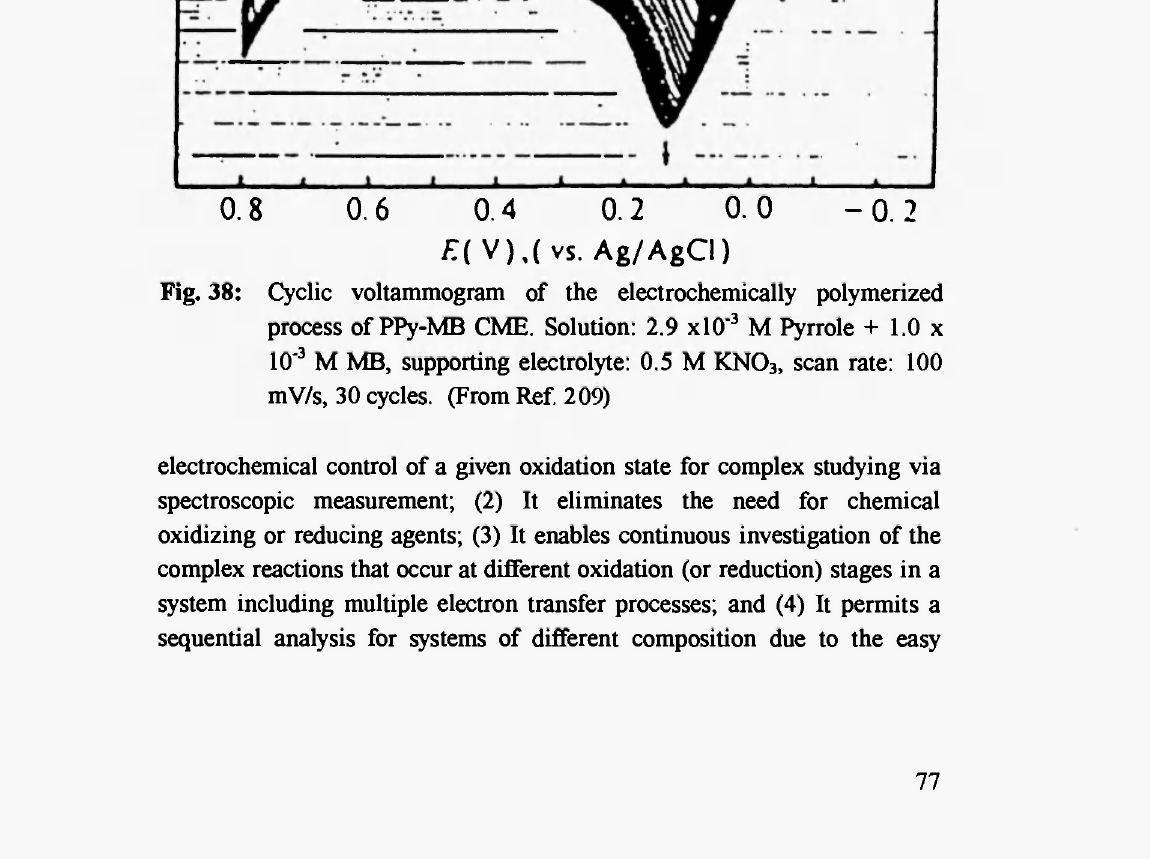
Fig. 38: Cyclic voltammogram of the electrochemically polymerized process of PPy-MB CME. Solution: 2.9 xlO' 3 Μ Pyrrole + 1.0 χ 10" 3 Μ MB, supporting electrolyte: 0.5 Μ KN0 mV/s, 30 cycles. (From Ref.